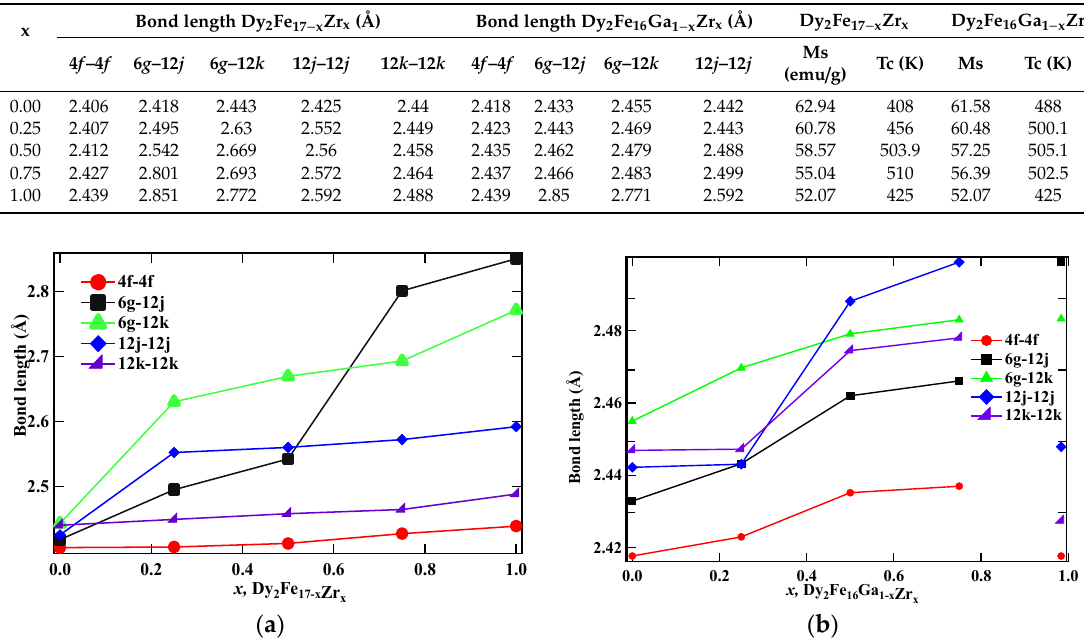
Table 3. Distance between the Fe–Fe neighbor sites, Ms, and Tc for Dy 2 Fe 17 − x Zr x and Dy 2 Fe 16 Ga 1 − x Zr x . x